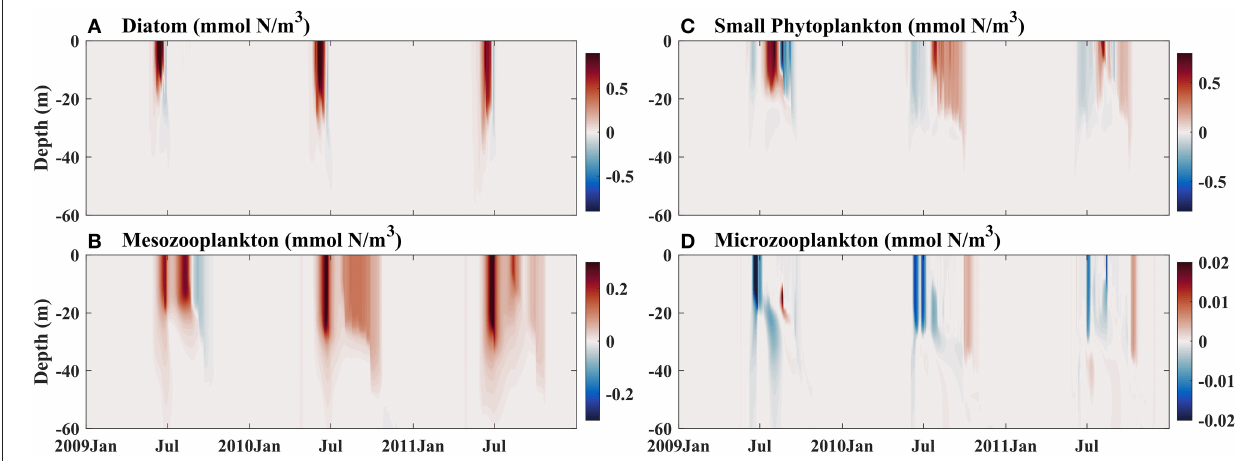
FIGURE 10 | Modeled vertical distributions of differences in (A) diatoms (mmol N/m 3 ), (B) small phytoplankton (mmol N/m 3 ), (C) mesozooplankton (mmol N/m 3 ), and (D) microzooplankton (mmol N/m 3 ) between the control run and sensitivity experiment Exp 1, which was forced with two times the dissolved Fe dust deposition after 2009, at Stn.